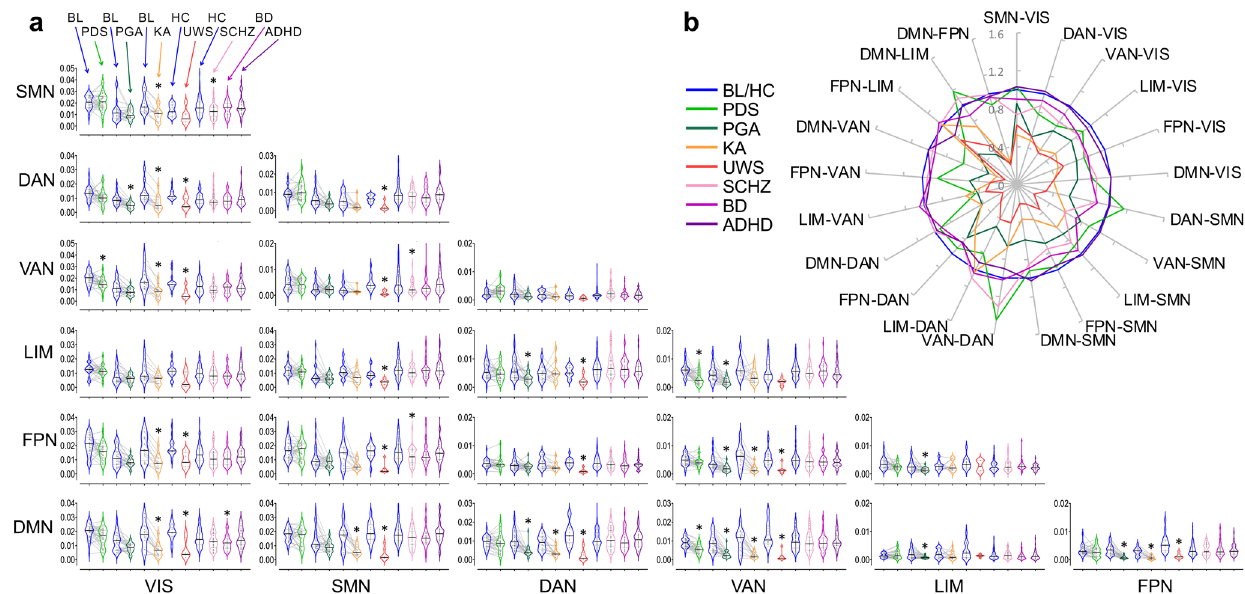
Fig. 5 | Network distance in various states of consciousness. a Violin plots (median:solidline;quantiles:dashline)ofpair-wisenetworkdistance,measuredby the Euclidean distance between the centroids of two networks in the 3D gradient space, across all conditions. Bayesian paired samples T tests (two-tailed) were performed for propofol deep sedation (PDS; n =26), propofol general anesthesia (PGA; n =23), and ketamine anesthesia (KA; n =12) against their own baseline conditions(BL; n =26, n =23, n =12,respectively).BayesianIndependentSamples T tests (two-tailed) were performed for unresponsive wakefulness syndrome (UWS; n =7), schizophrenia (SCHZ; n =44), bipolar disorder (BD; n =49), and attention